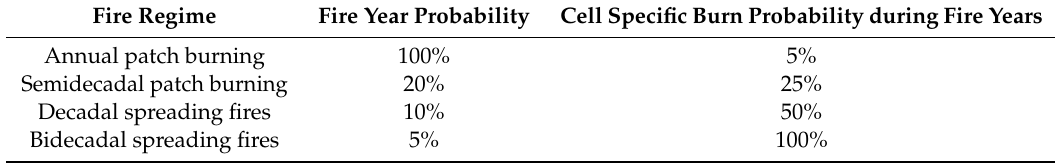
Table 1. Description of the probability used to determine whether a time-step was a fire year, and the probability that each cell would burn in a fire year for each of the four modeled fire regimes. Note that all four fire regimes have a natural fire rotation of 20 years within which an area equal to 100% of the landscape could